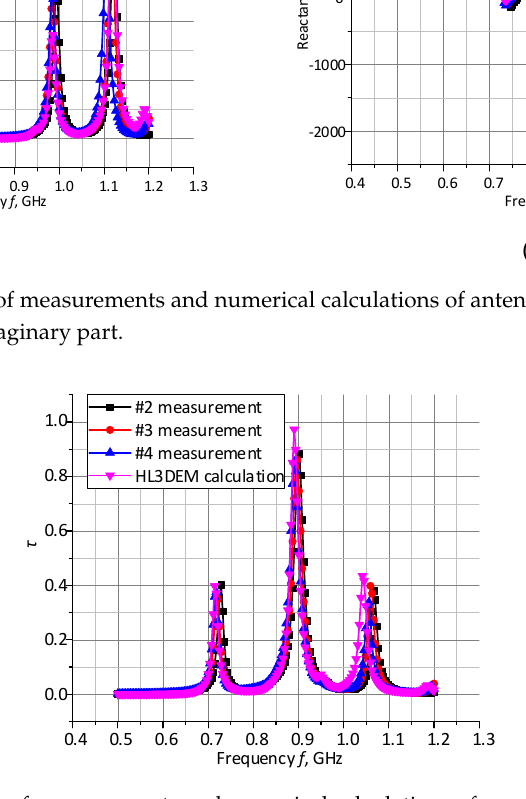
Figure 12. Comparison of measurements and numerical calculations of power transfer coefficient.